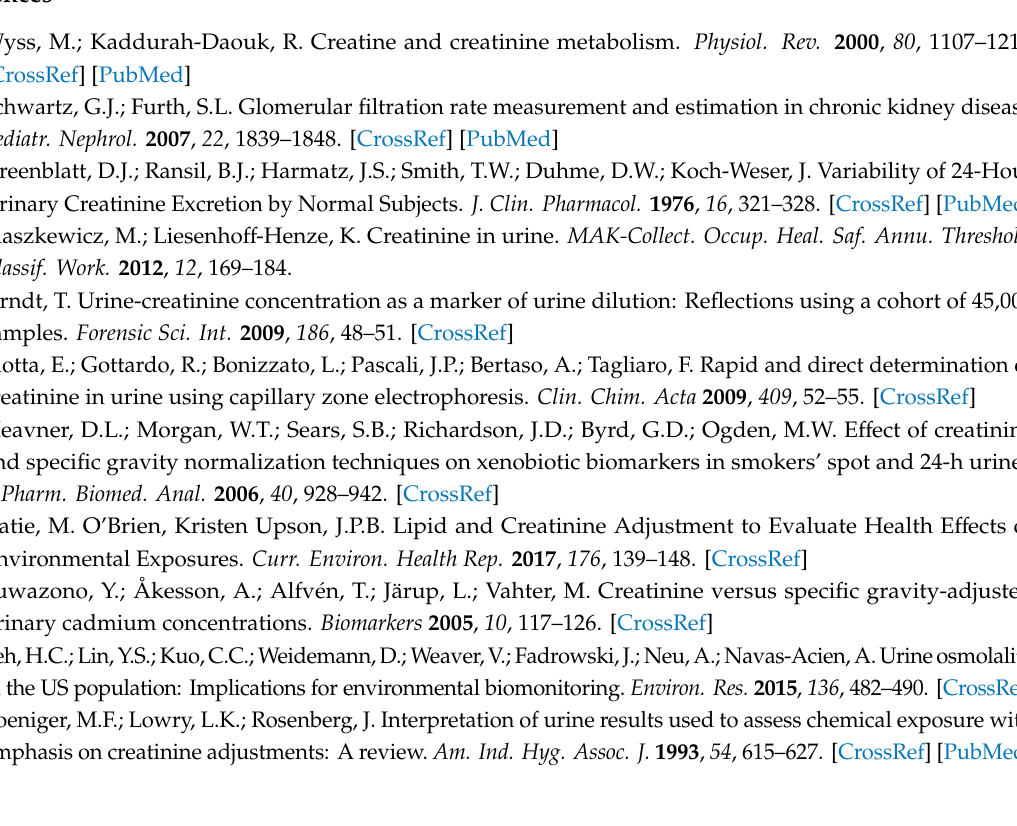
Table S1: Human biomonitoring studies, in which the ratio between mycotoxin concentration and creatinine content of urine was